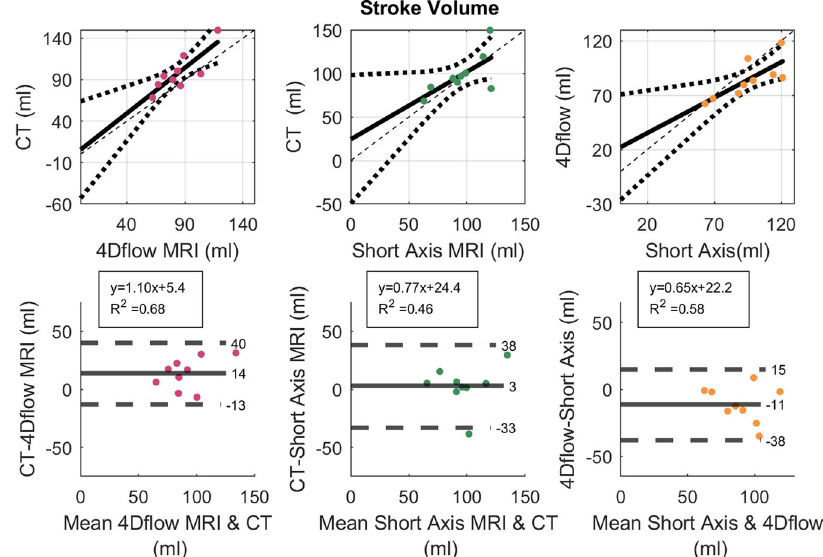
Fig. 4 Comparison of Ventricular Stroke Volume measured with CT, 4D fl ow MRI and Short Axis MRI. In the comparison of CT and Short Axis MRI, the differences between the measurements were not normal distributed, so the limits of agreement might be overestimated Top: Solid line indicates Linear Regression line; Dotted lines indicate 95% con fi dence bounds; Dashed line indicates identity line. The box shows the linear regression equation and the coef fi cient of determination R 2 . Bottom: Bland-Altman Plot; Solid line indicates the bias, Dashed lines indicate ±1.96 standard deviation.